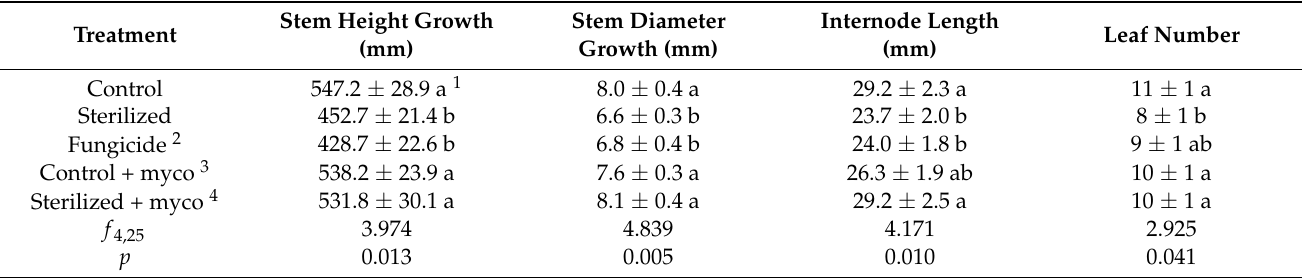
Table 9. The influence of growing Serianthes grandiflora plants in soil obtained from Serianthes grandiflora rhizosphere on plant growth traits. Mean ± SE, n =